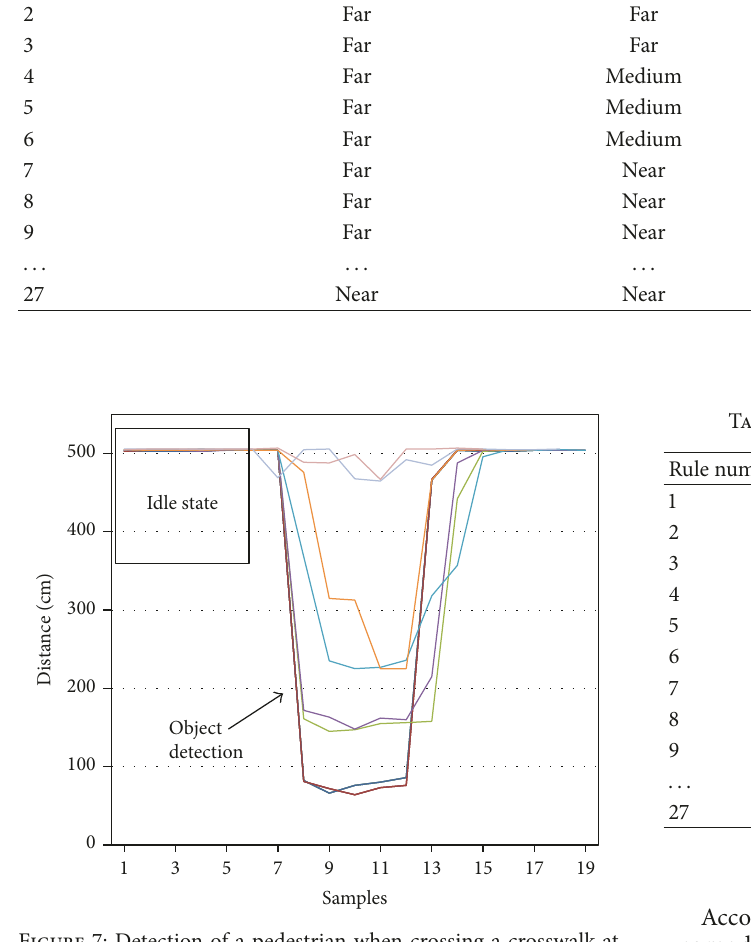
Figure 7: Detection of a pedestrian when crossing a crosswalk at different distances expressed in several colors. Blue and red show the detection of a pedestrian crossing at 100cm away from the sensor, green and purple crossing at 200 cm, orange and light blue crossing at 300 cm, and pink and light purple crossing at 400 cm. For each distance there are two colors meaning the test crossing from right to left and vice versa. The range measurements taken by the sensor are shown on the 𝑦 -axis while the temporary samples are observed on the 𝑥 -axis.